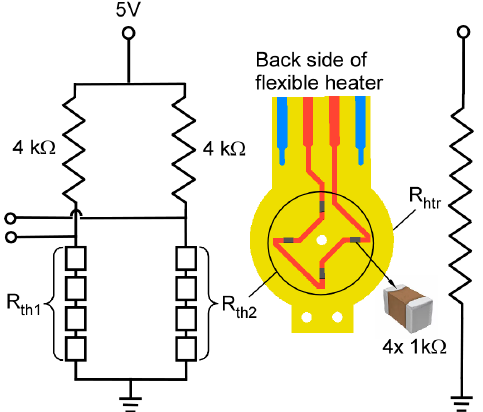
Figure 2. Design of the customized flexible heater with heating metal trace ( R htr ) on the front side and integrated thermistors ( R th1 , R th2 ) on the back side. An external voltage divider circuit is used to measure the change of electrical resistance of the thermistors.